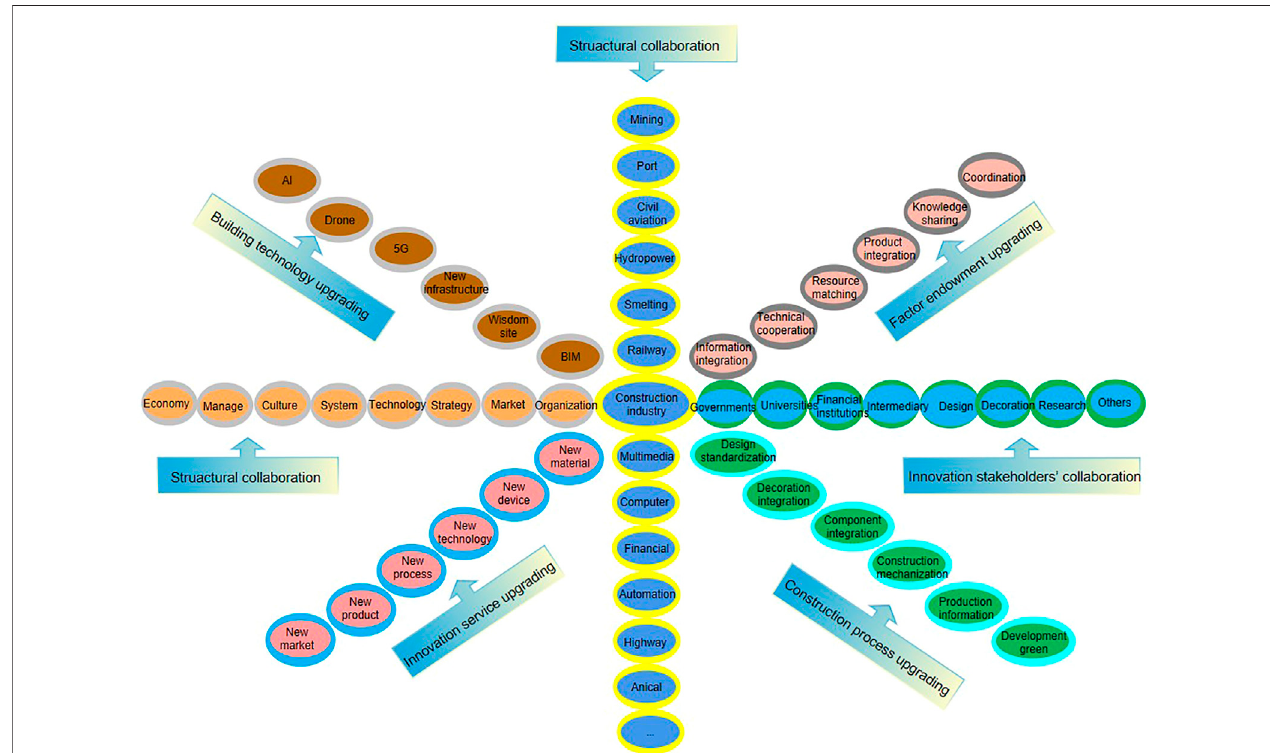
FIGURE 5 | “ mi ” -shaped conceptual framework in the collaborative development of ICBI.